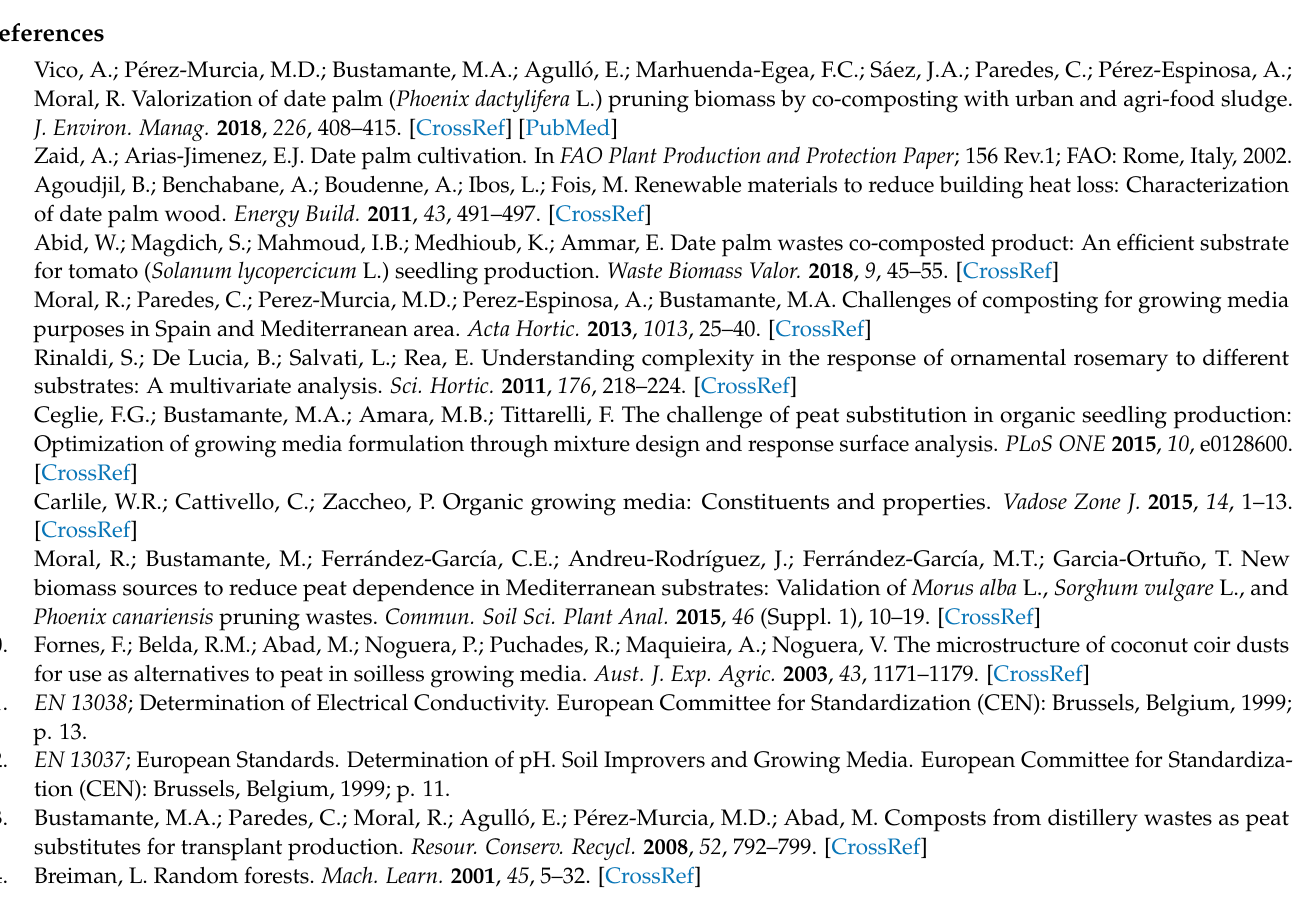
Table S2: Germination and morphological characteristics of lettuce seedlings grown in the substrates studied analysed with ANOVA and post-hoc Tukey-b